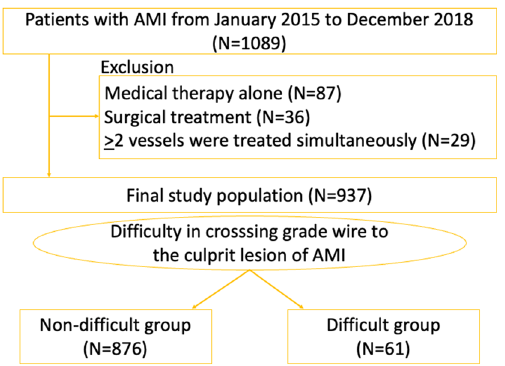
Figure 1. The study flow-chart. Abbreviations: AMI = acute myocardial